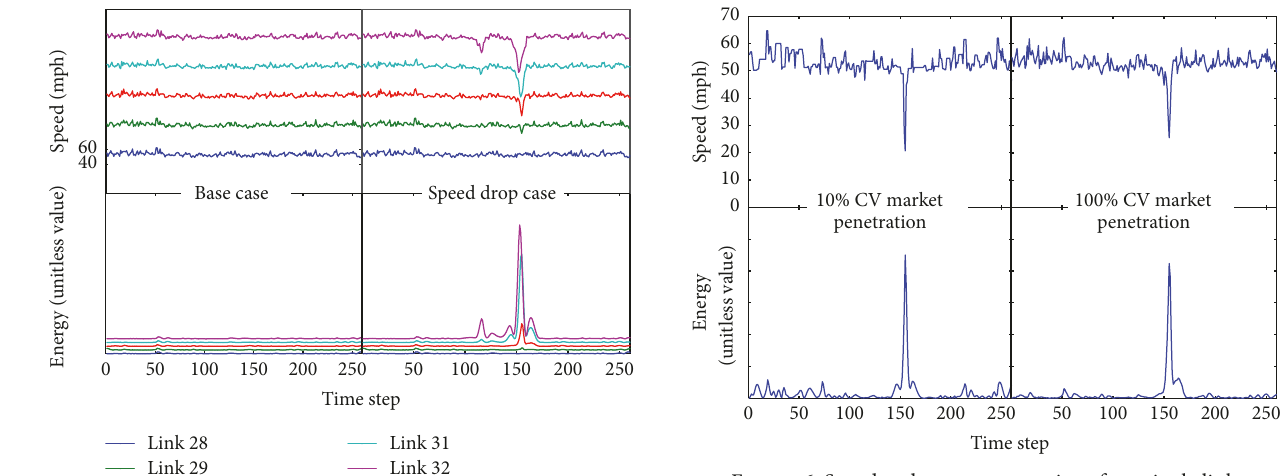
Figure 6: Speed and energy comparison for a single